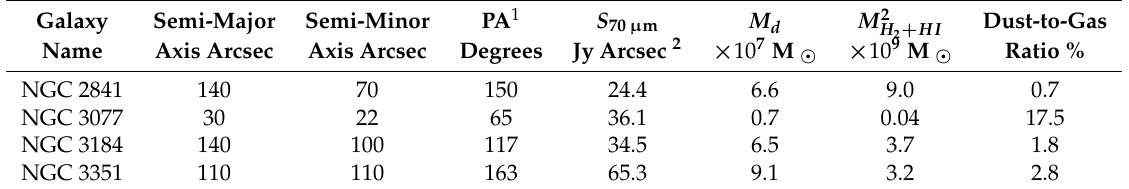
Table 2. Ellipse parameters and derived physical parameters for our sample of